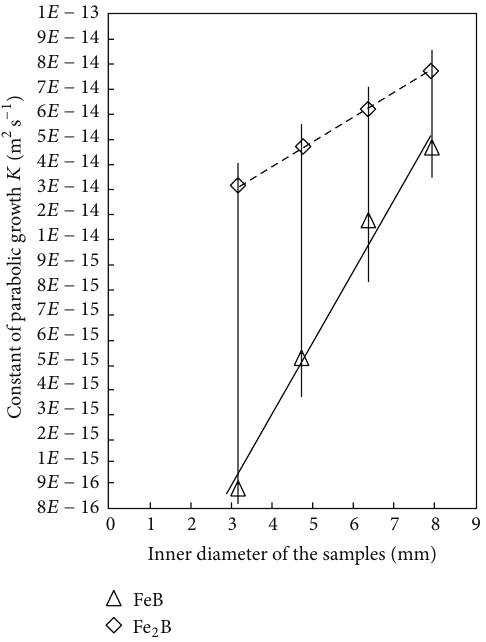
Figure 7: Constant of parabolic growth as a function of the boron potential represented by the inner diameter of the